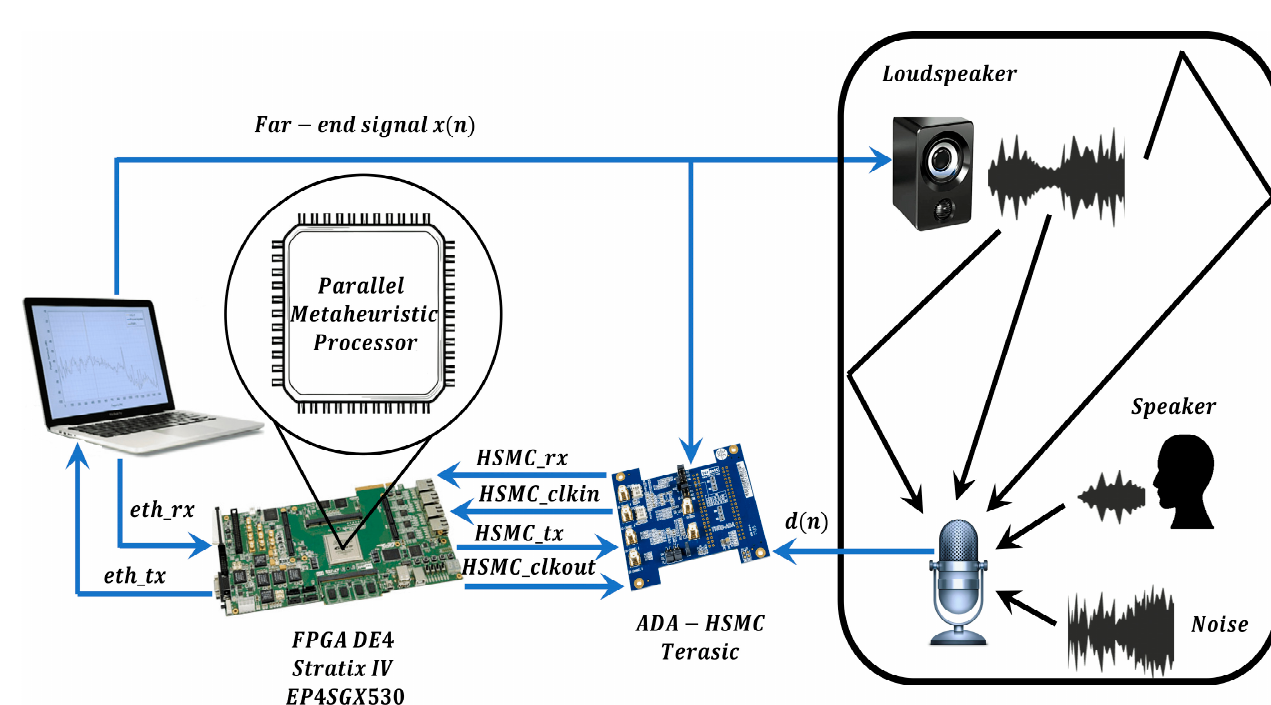
Figure 10. General scheme of the components of the AEC